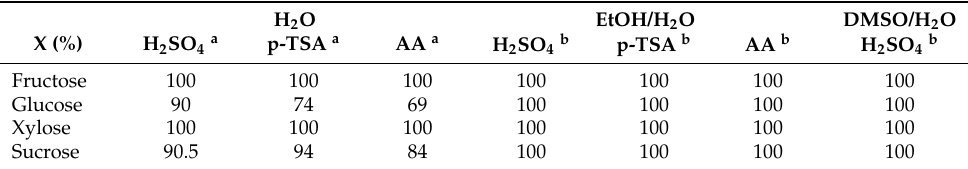
Table 2. Sugar conversion in humin formation